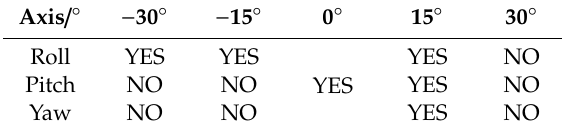
Figure 6. The colour bar represents the range of deviations and the colour to represent it throughout this paper. For angle estimates, the range of deviation is ± 0.278 rad whereas, for the position, the range of deviation is ± 0.002 m. Each little square in Figure 7 represents a relative position of the Aruco tag in the frame with its neighboring pixels; for example, the deviation for the measurement in Figure 5a would be represented by the highlighted little square approximately in the center of the grid in Figure 7a. The deviation map remained almost consistent across several iterations of the same measurement (for the same angle and distance); an example of this can be observed in Figure 7, where a, b and c are